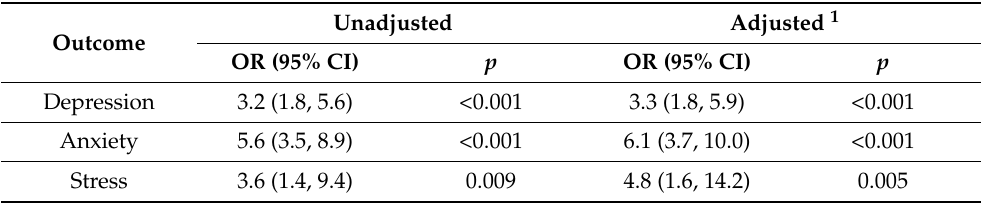
Table 3. Association of household food insecurity with mental health among early-gestation pregnant women in